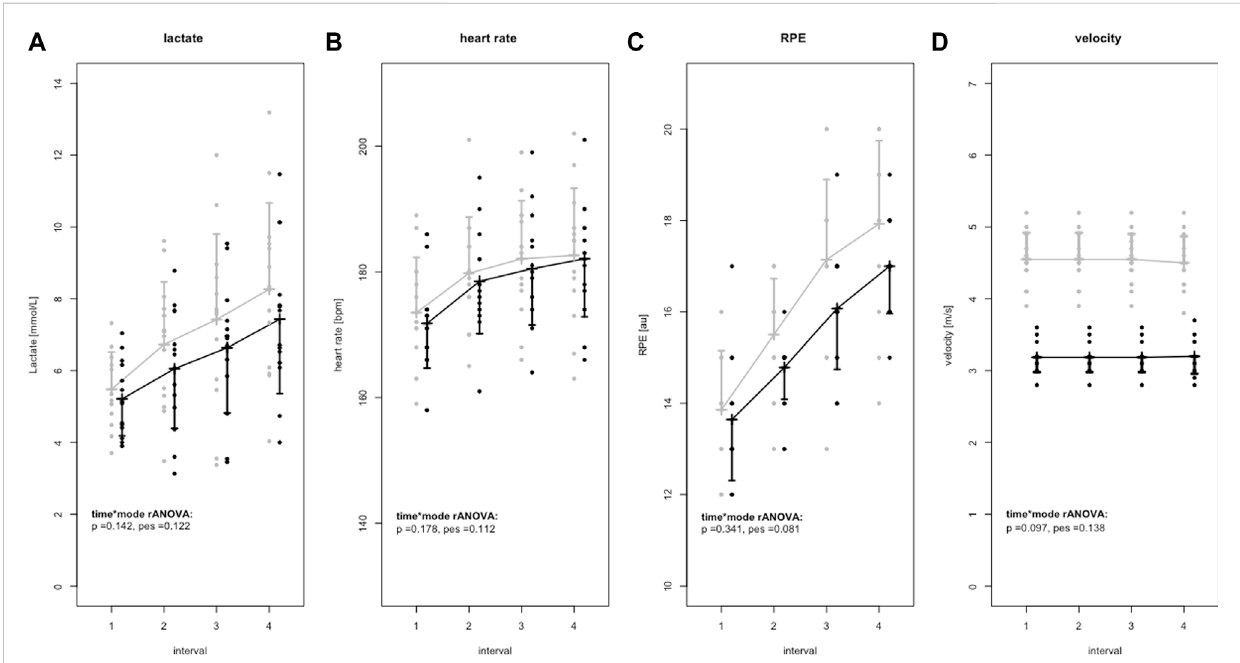
FIGURE 2 Lactate (A) , heart rate (B) , RPE (C) , and running velocity (D) data (mean ± standard deviation) of horizontal (grey) and uphill (black) high intensity training protocols. Individual values are marked as points. In addition, p -values of time*mode interaction effects ( p ) of the repeated measurement variance analyses (rANOVA) and corresponding effect sizes as partial eta squared (pes) are